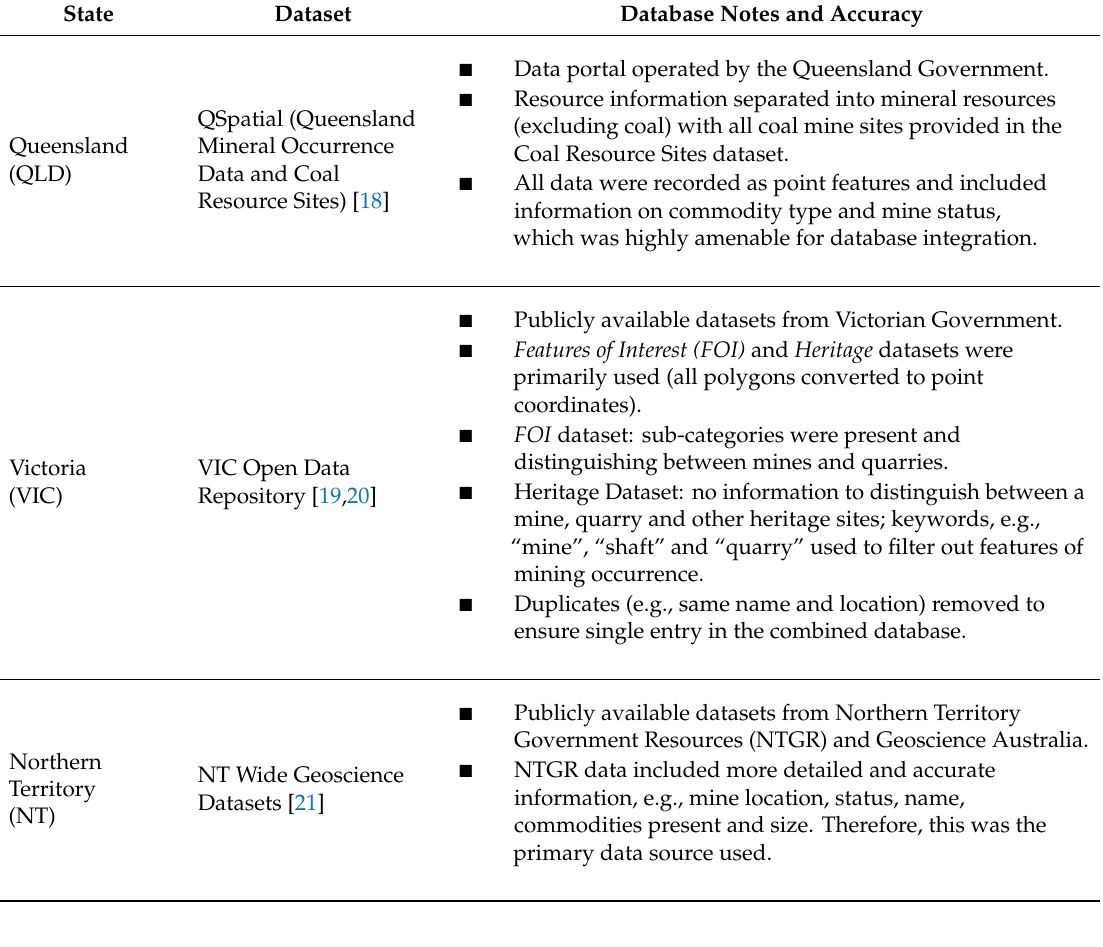
Table 1. Mining occurrence datasets that were used to create a combined database